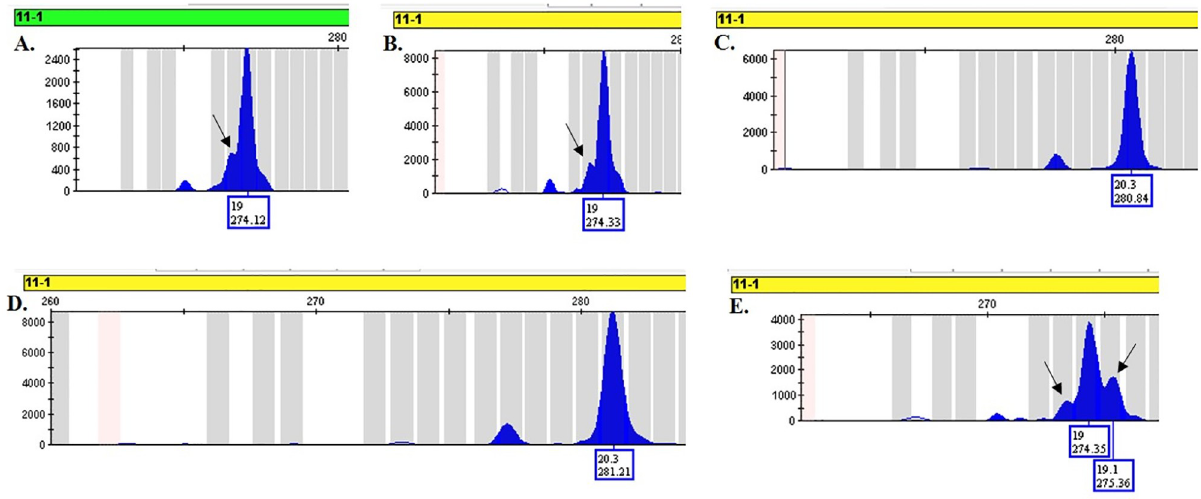
Fig 4. Peak morphology of STR marker 11–1. A. Arrow denotes irregular peak morphology of allele 19 from diploid DNA from an AKR mouse (Jackson Laboratories). B. Arrow denotes irregular peak morphology of allele 19 from the JC cancer cell line. C. Normal peak morphology of allele 20.3 from diploid DNA from C58 mouse (Jackson Laboratories). D. Normal peak morphology of allele 20.3 from the CMT-93 cancer cell line. E. Arrows denote irregular peak morphology of allele 19 from the CT26.CL25 cancer cell line.